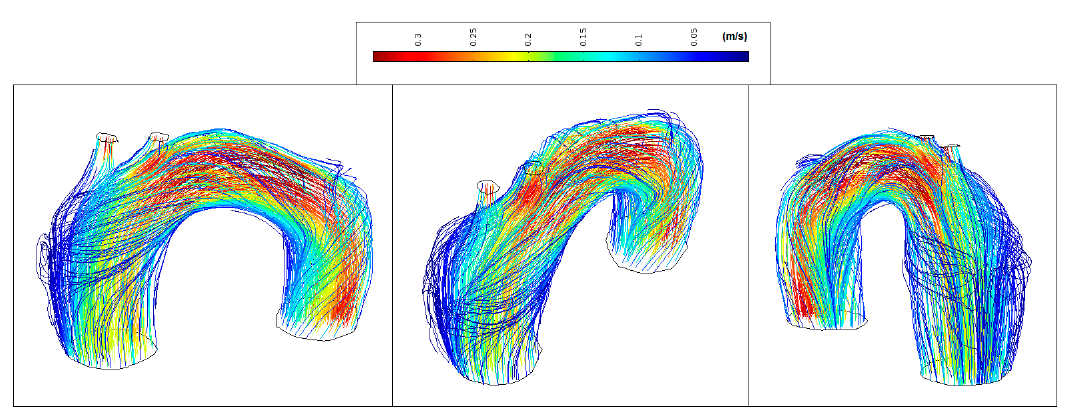
Figure 12. Patient 1: velocity streamlines (peak systole).